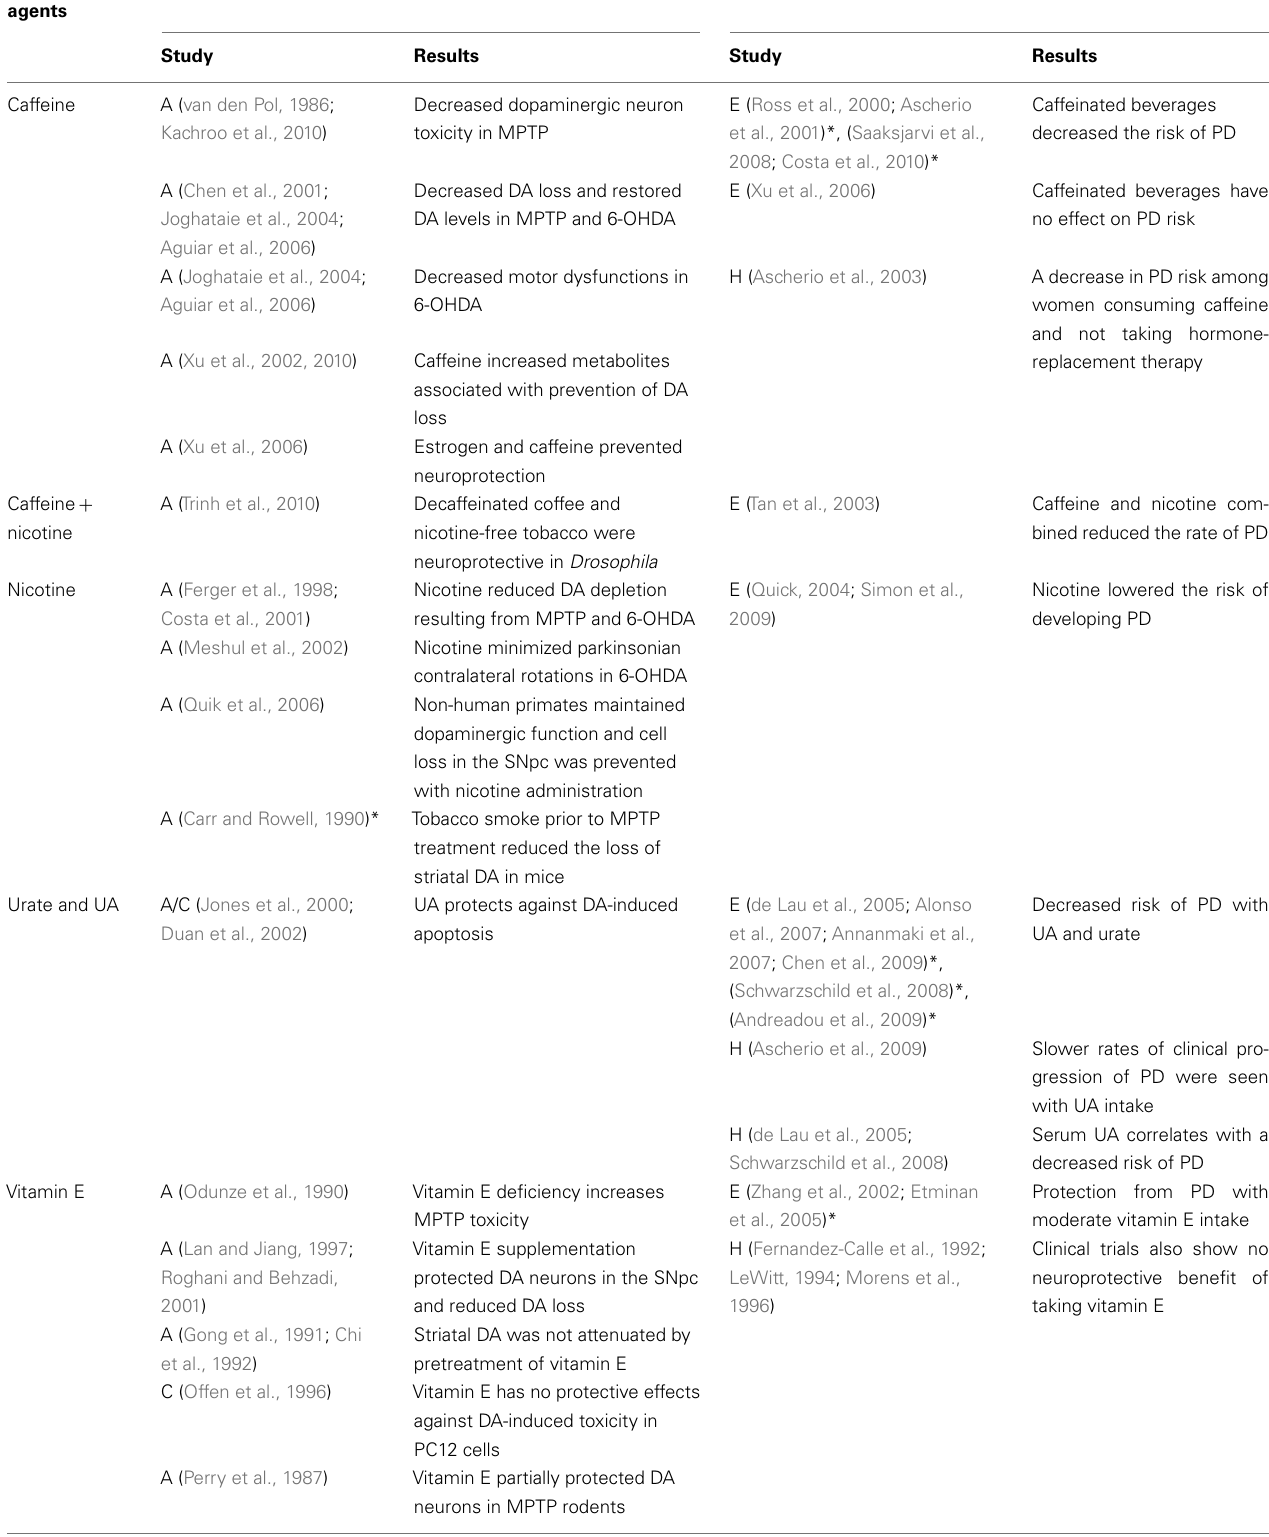
Table 1 | Neuroprotective agents in PD